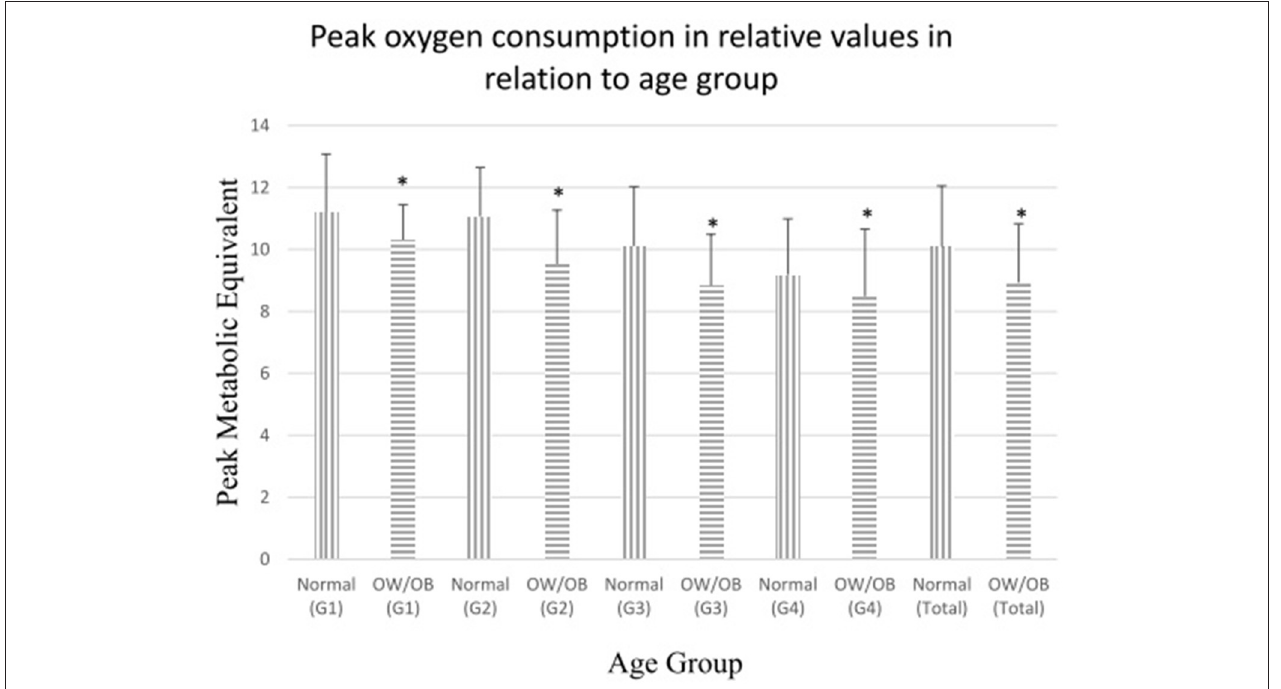
FIGURE 2 | Comparisons of peak oxygen consumption in relative values (metabolic equivalent) between children with normal and overweight/obese body mass index. Peak oxygen consumption in relative values (metabolic equivalent) in normal-weight/non-obese and overweight/obese children. OW/OB =